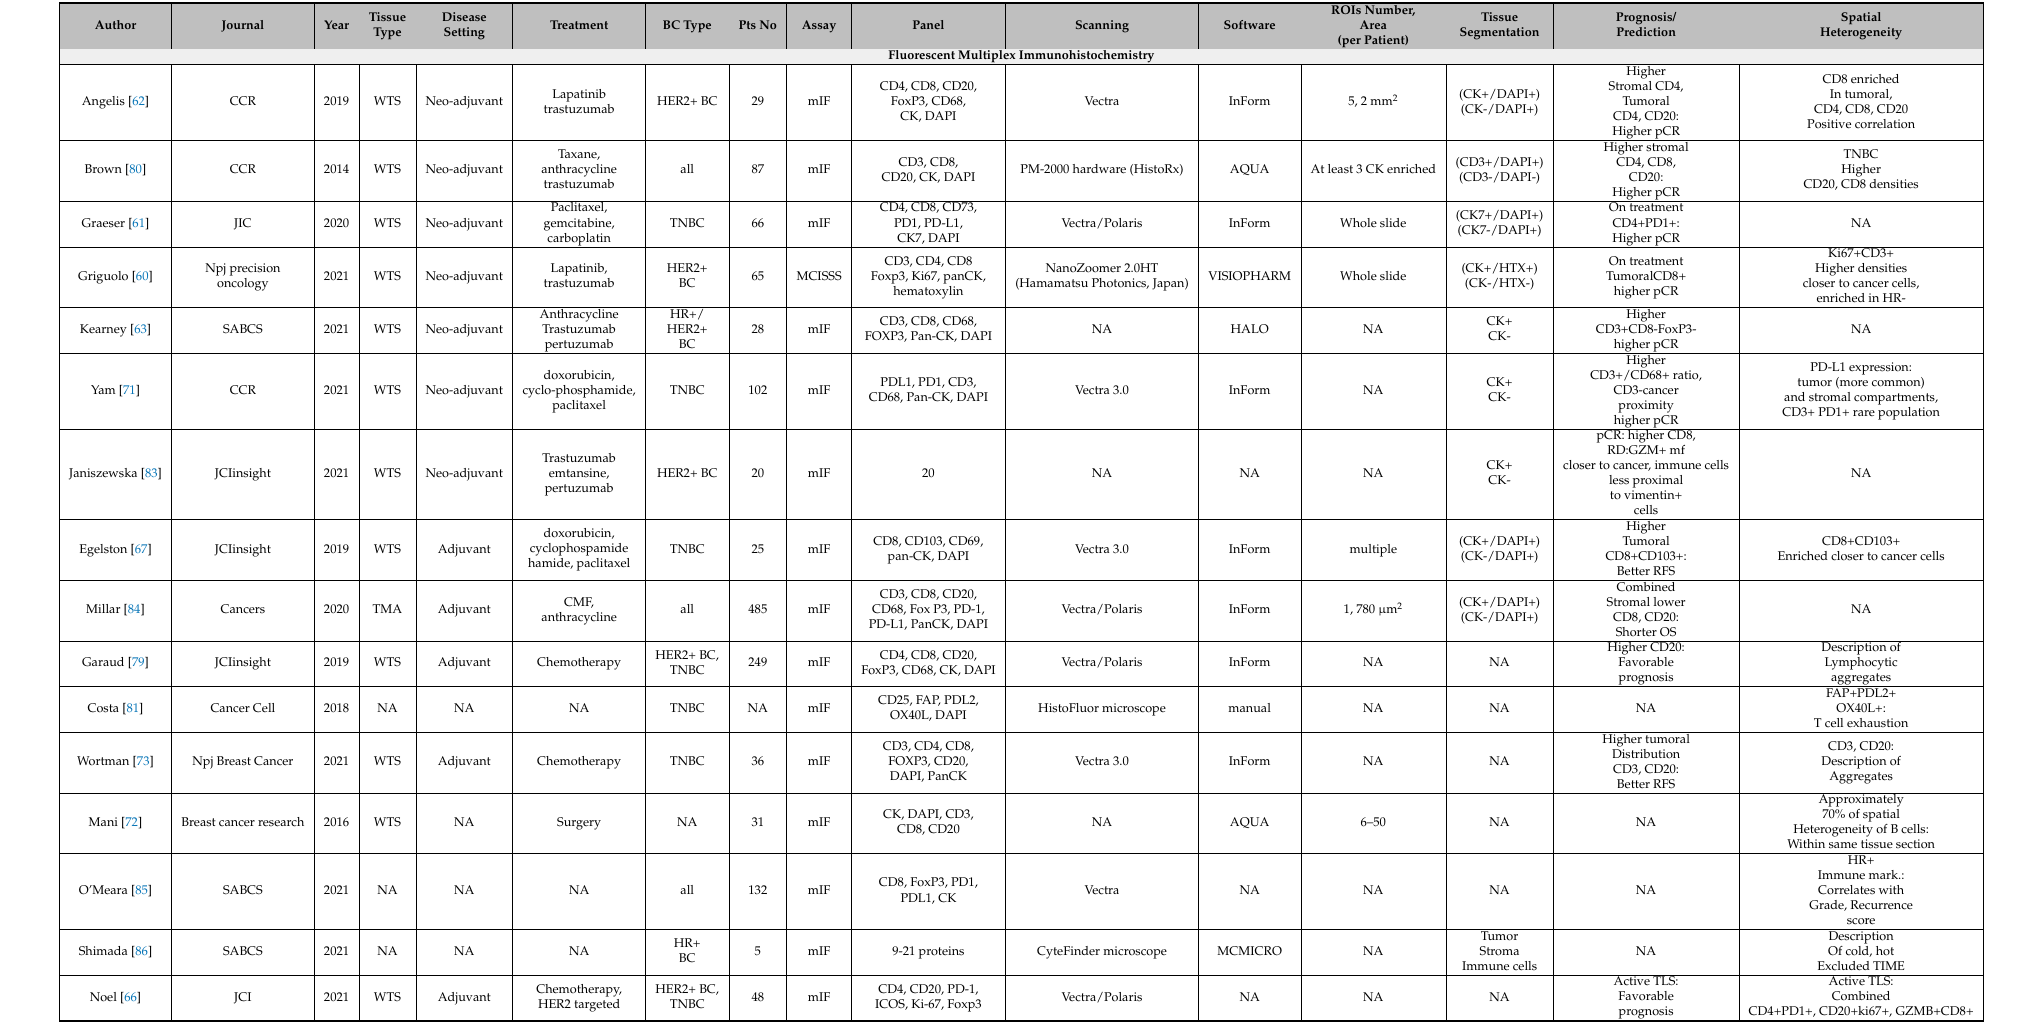
Table 3. Breast cancer studies; Characteristics, Prognosis/Prediction,